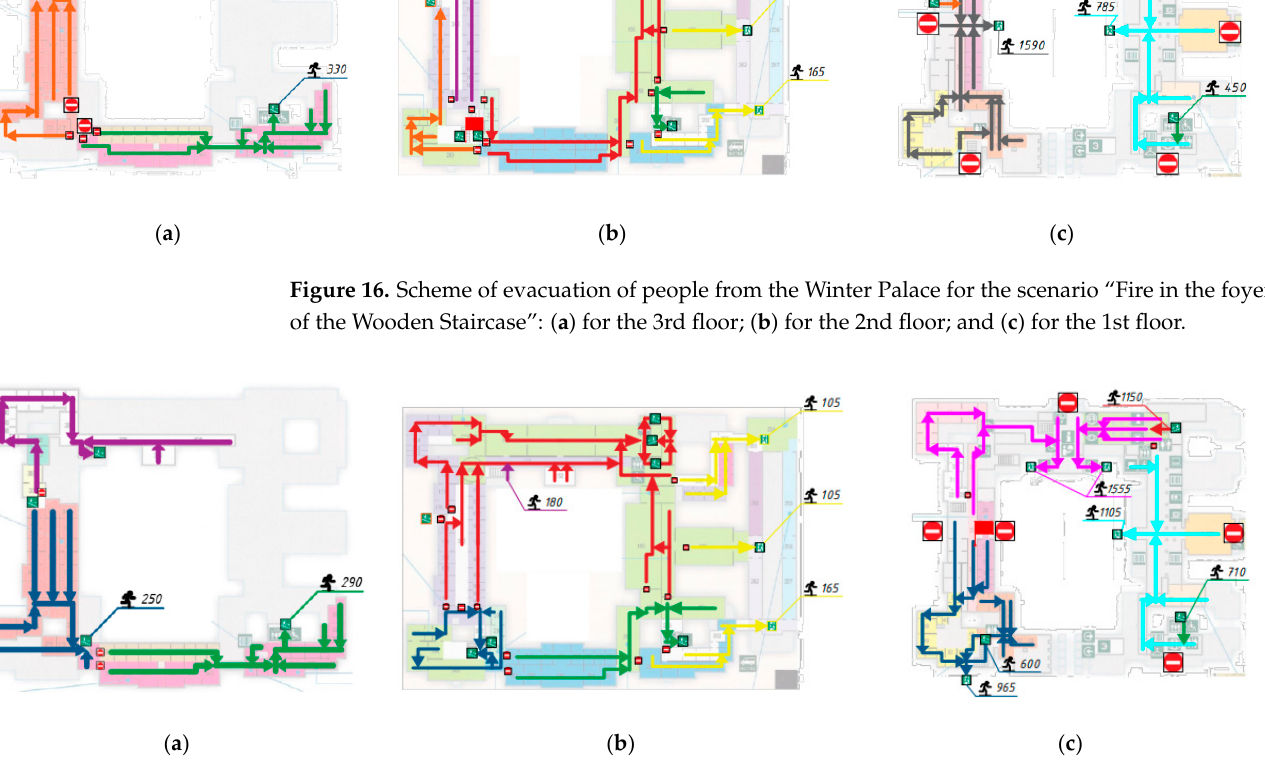
Figure 17. Scheme of evacuation of people from the Winter Palace for the scenario “Fire in the Saltykov’s Entrance”: ( a ) for the 3rd floor; ( b ) for the 2nd floor; and ( c ) for the 1st floor.